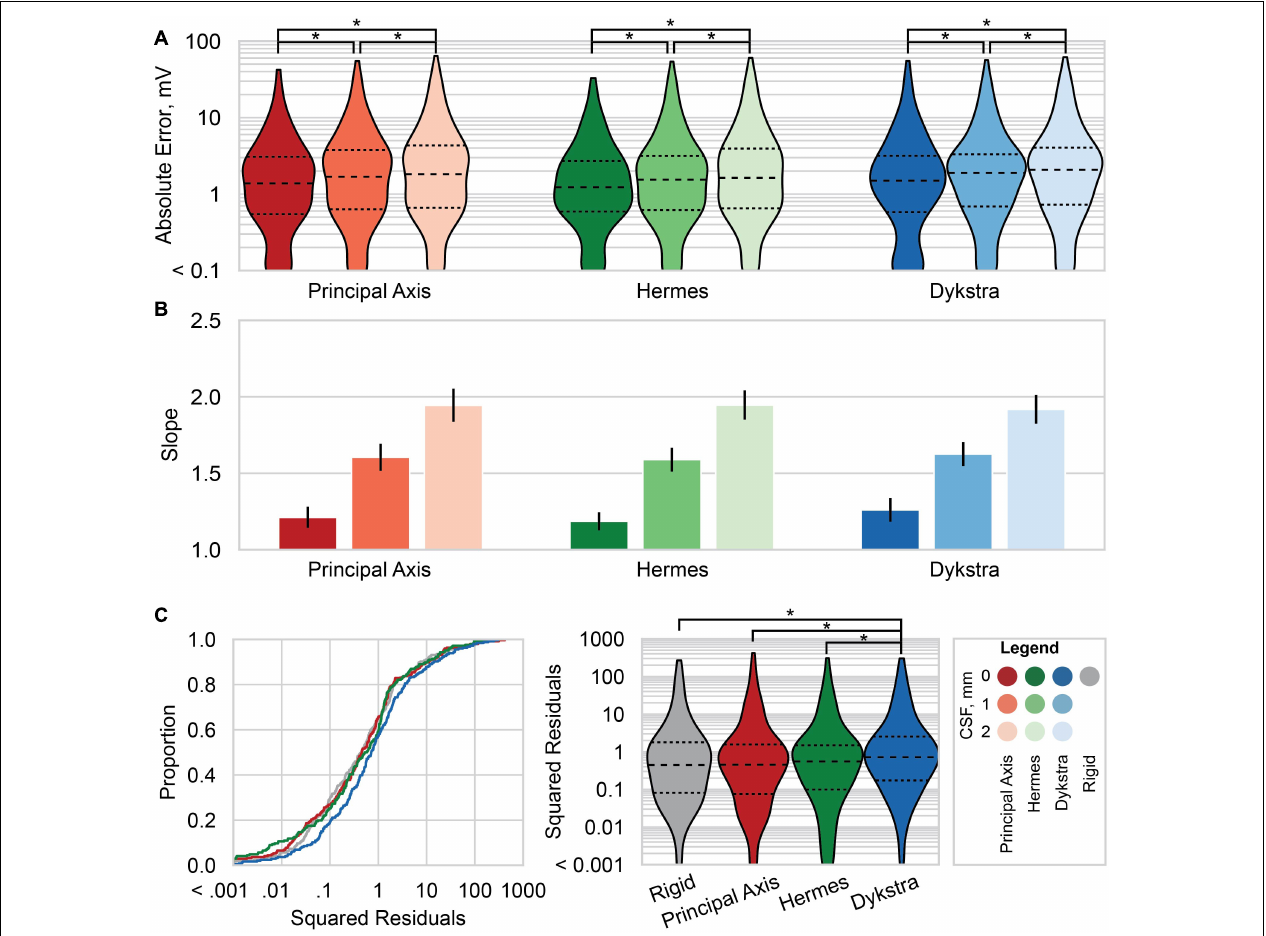
FIGURE 6 | Absolute errors and linear regression results across patients. (A) Violin plots of the absolute error between the predicted and recorded voltages for each electrode localization method: principal axis (red), Hermes (green), and Dykstra (blue) at–from left to right within each method–0, 1, and 2 mm of CSF. Results for the principal axis and Hermes methods summarize all six patients; results for Dykstra comprise only the four patients for whom that method converged. Dashed line is the median, and smaller dashed lines bound the interquartile range. (B) The slope of the linear regression of the predicted and recorded voltages at a stimulation amplitude of 1 mA across all patients for each electrode localization method and CSF depth. The linear regressions are across six patients for the principal axis and Hermes methods, and across four patients for the Dykstra method. The error bars show the 95% confidence interval of the slope. Slopes closer to one better predict the magnitudes of the recorded voltages. (C) The squared residuals of the linear regression of the predicted and recorded voltages at a stimulation amplitude of 1 mA across the four patients for whom all electrode localization methods worked (patients 1–4). Shown are both the empirical cumulative distribution function of the squared residuals ( left ) and violin plots of the squared residuals ( right ). Significant pairwise comparisons between (A) CSF levels within a projection method and (C) between electrode projection methods after correction for multiple comparisons are shown with * p < 10 - 4